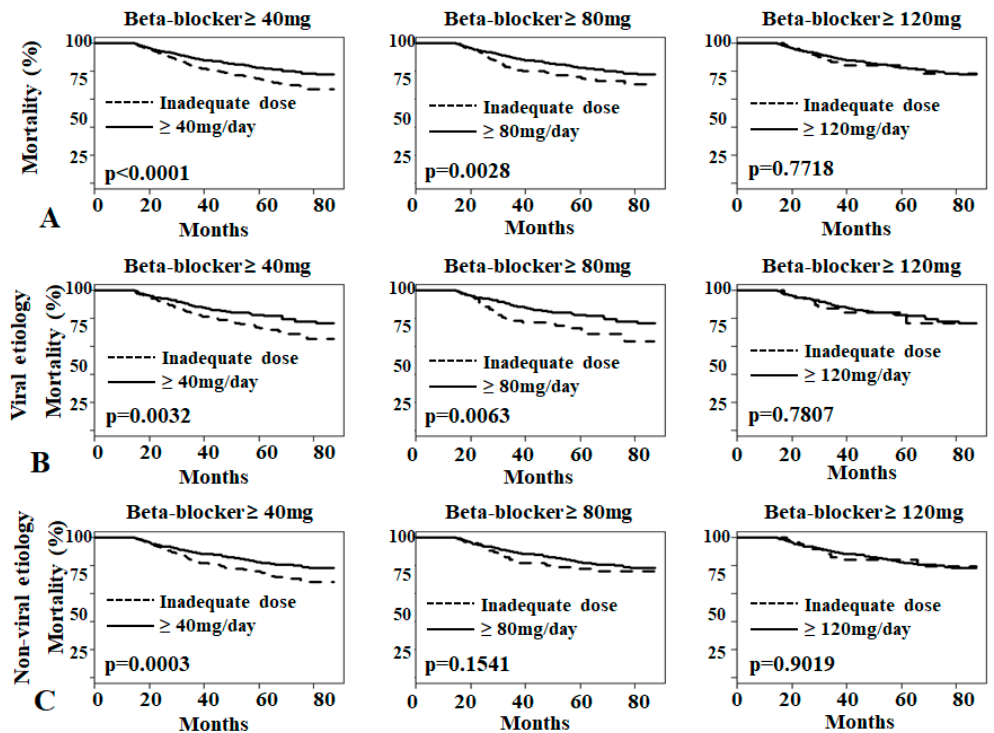
Figure 3. Mortality due to various doses of non-selective beta-blockers in patients with large-volume ascites. ( A ) Overall mortality rate due to various dosages of non-selective beta-blockers (NSBB). ( B ) Overall mortality rate due to various dosages of NSBB in patients with viral cirrhosis. ( C ) Overall mortality rate due to various dosages of NSBB in patients with non-viral cirrhosis.